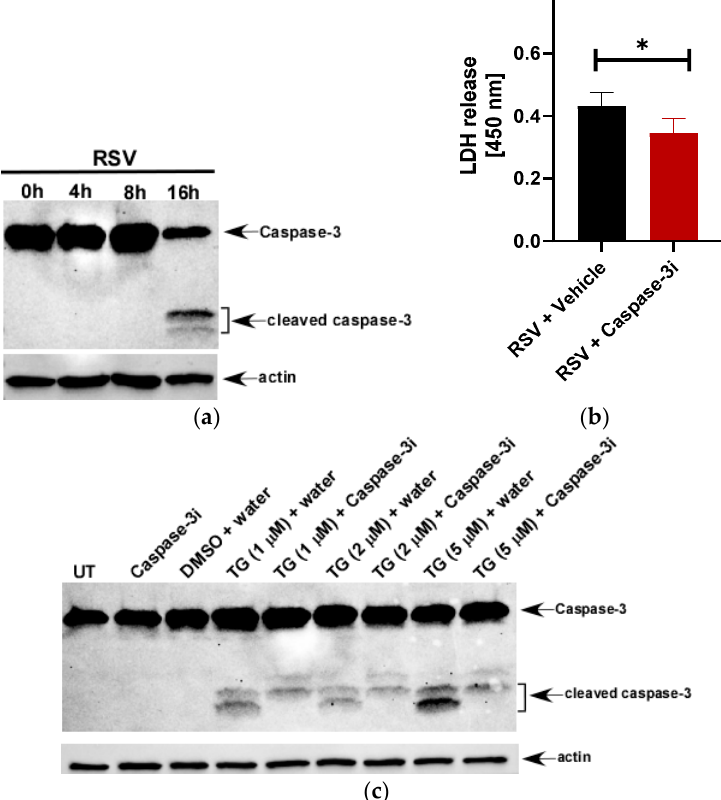
Figure 2. LDH release during RSV infection of macrophages is primarily due to lytic cell death. ( a ) Human THP-1 macrophages infected with RSV (MOI = 1) for 0 h–16 h were subjected to Western blotting with anti-caspase-3 antibody that can detect both the full length and cleaved fragments of activated caspase-3. ( b ) Human THP-1 macrophages were infected with RSV (MOI = 1) in the presence of either vehicle (water) or the caspase-3 inhibitor Ac-DEVD-CHO (100 µ M). LDH release was measured (at OD of 450 nm) at 16 h post-infection ( n = 16 technical replicates from two independent experiments). * p ≤ 0.05 using a Student’s t -test. ( c ) Untreated (UT) and THP-1 cells treated with indicated concentrations of thapsigargin (TG) in the presence of either water (vehicle control) or caspase-3 inhibitor Ac-DEVD-CHO (100 µ M) for 48 h were subjected to Western blotting with anti-caspase-3 antibody that can detect both the full length and cleaved fragments of activated caspase-3. TG is soluble in DMSO and therefore, a lane for DMSO + water was included for the Western blot analysis. Western blot data is representative of two-three independent experiments with